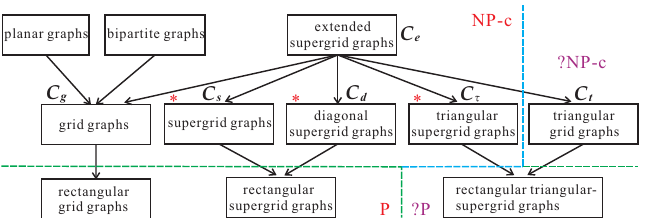
Figure 14. The complexities of the domination and independent domination problems for the classes of extended supergrid graphs. NP-c = NP-complete, P = Polynomial, * = this paper solved, ?NP-c = speculated to be NP-complete, and ?P = speculated to be